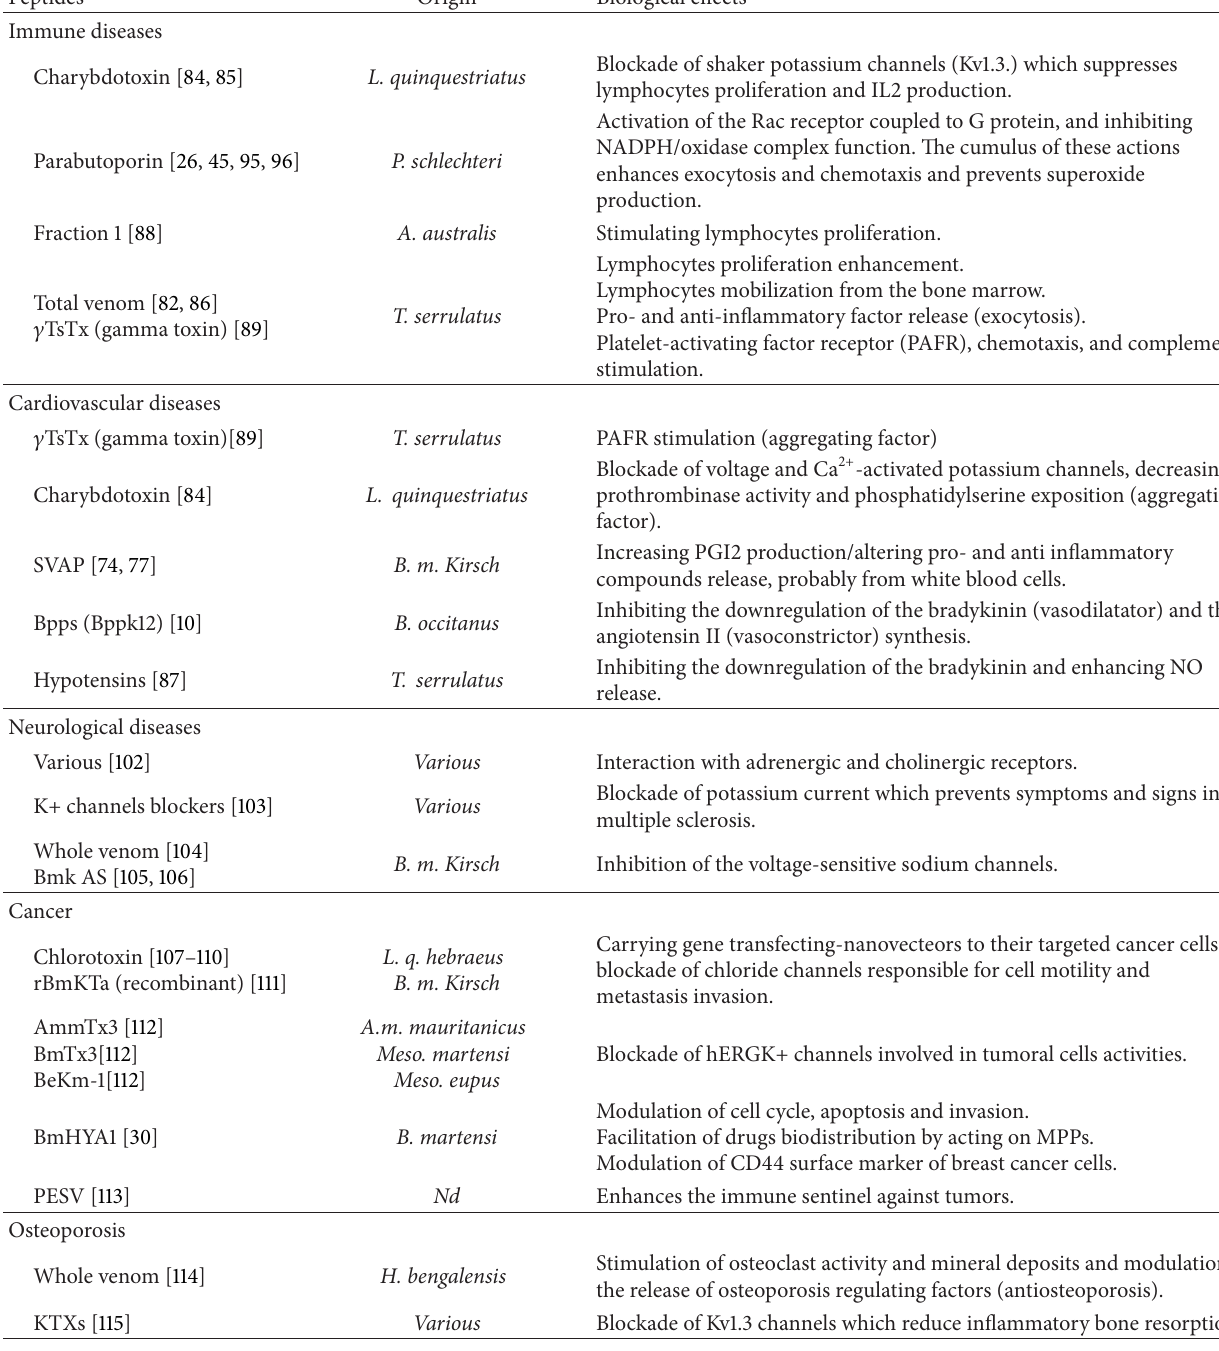
Table 4: Summary of the modus operandi of some scorpion derivatives with potential therapeutic use.